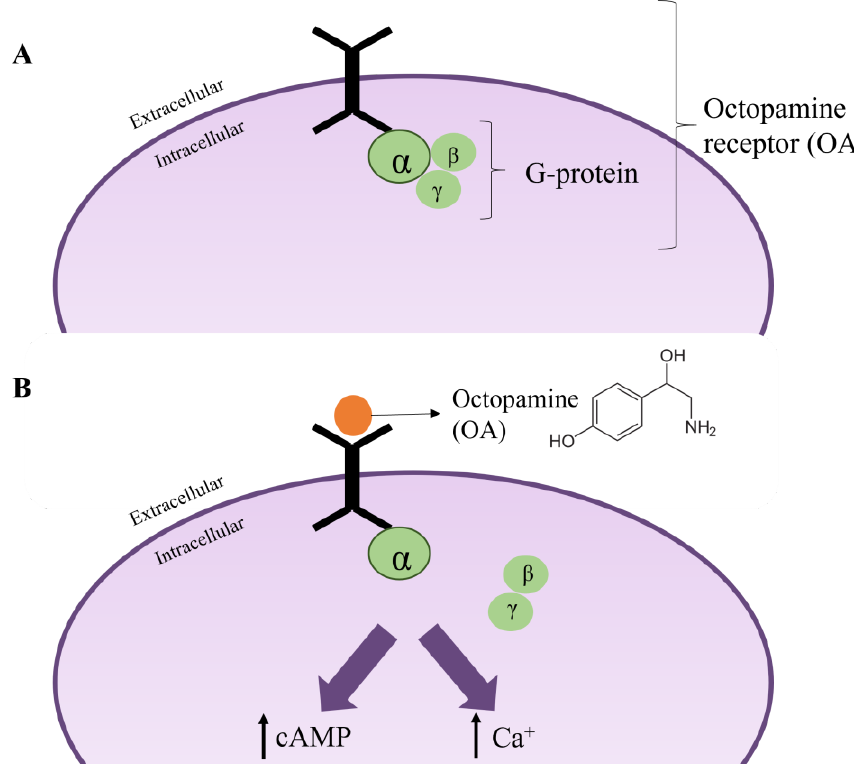
Figure 6. Functioning of the OA/OAr complex. ( A ) OA at rest. ( B ) Activation of OAr by OA binding. Modified from Jankowska et al.